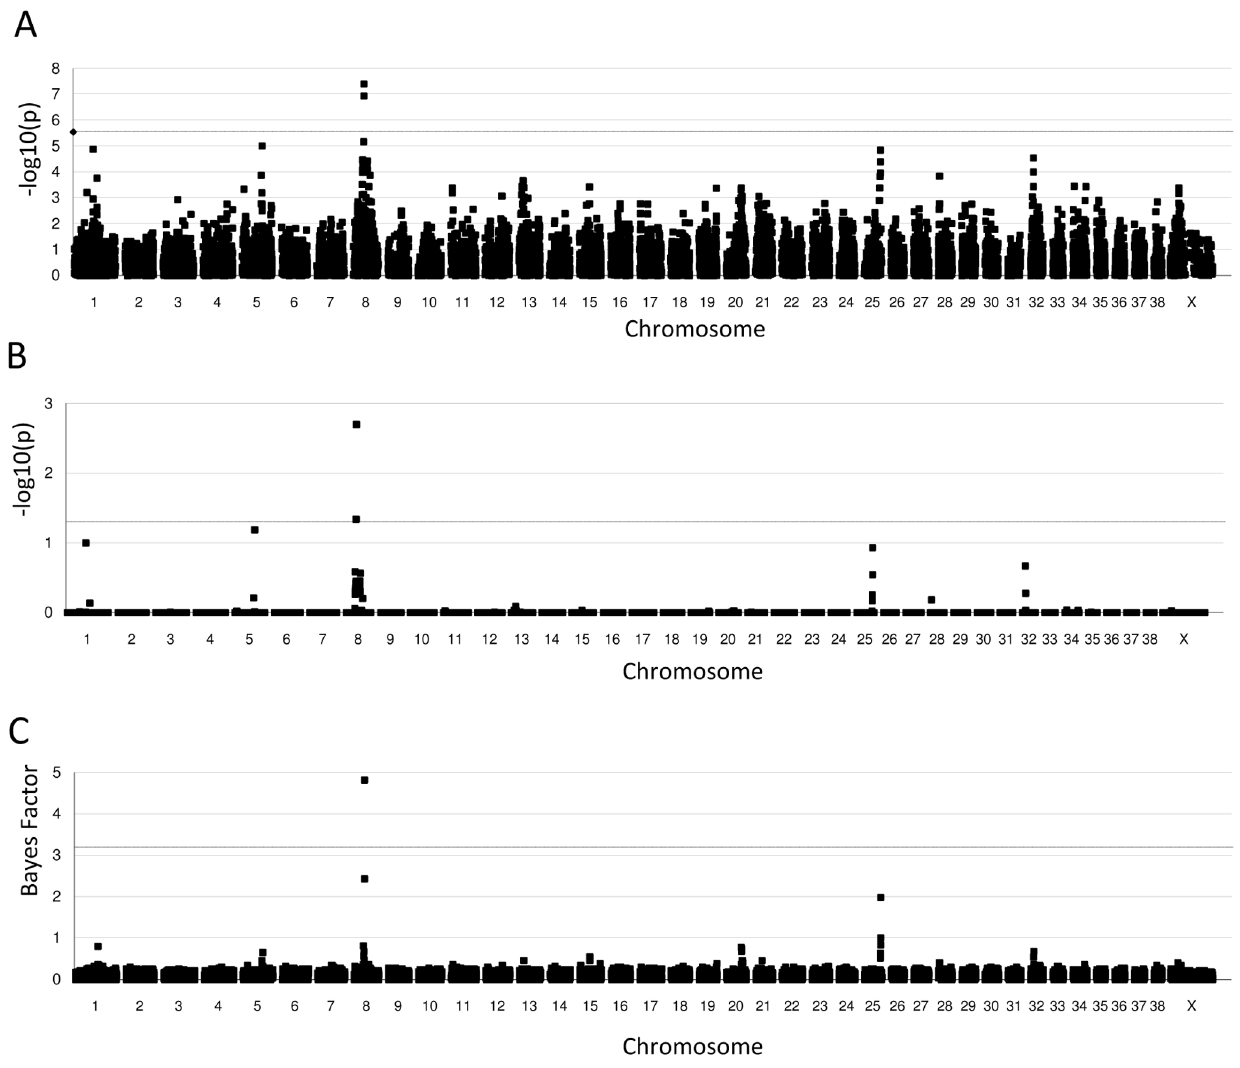
Figure 1. Genome wide association analysis of hip dysplasia in Labrador retrievers. Genotypes of 17,859 SNPs were compared between 48 cases and 30 controls. A. Allele frequency based x 2 statistics. The dotted line indicates the significance threshold after Bonferroni correction. B. Multiple testing correction of the x 2 statistics by 1,000 permutations of the phenotypes to determine empirical p-values. The dotted line indicates the significance threshold ( a =0.05). C. Genome wide association analysis using Bayesian variable selection to detect SNPs with a high probability to have an effect on the CHD phenotype. The dotted line indicates the significance level.